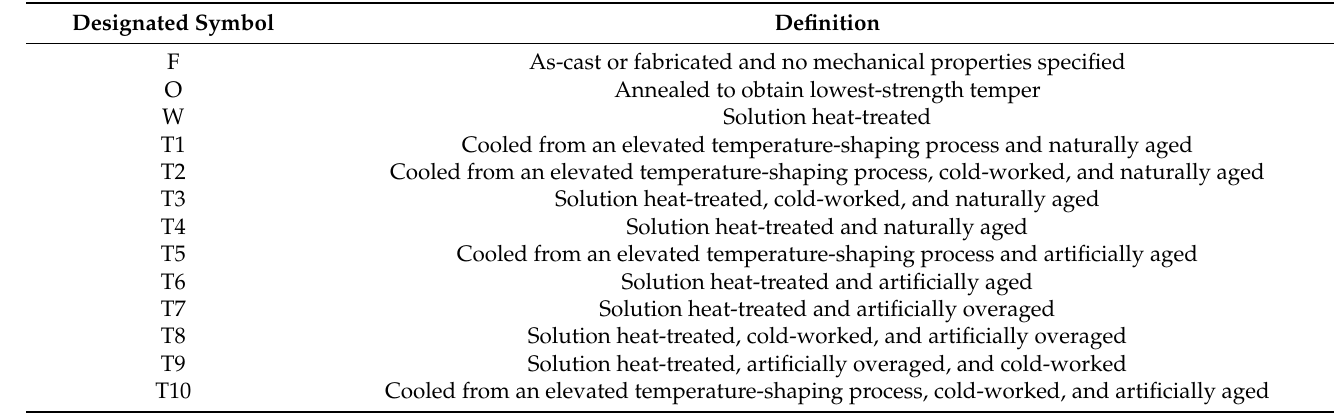
Table 2. Typical heat-treatment designations for Al-Si alloys